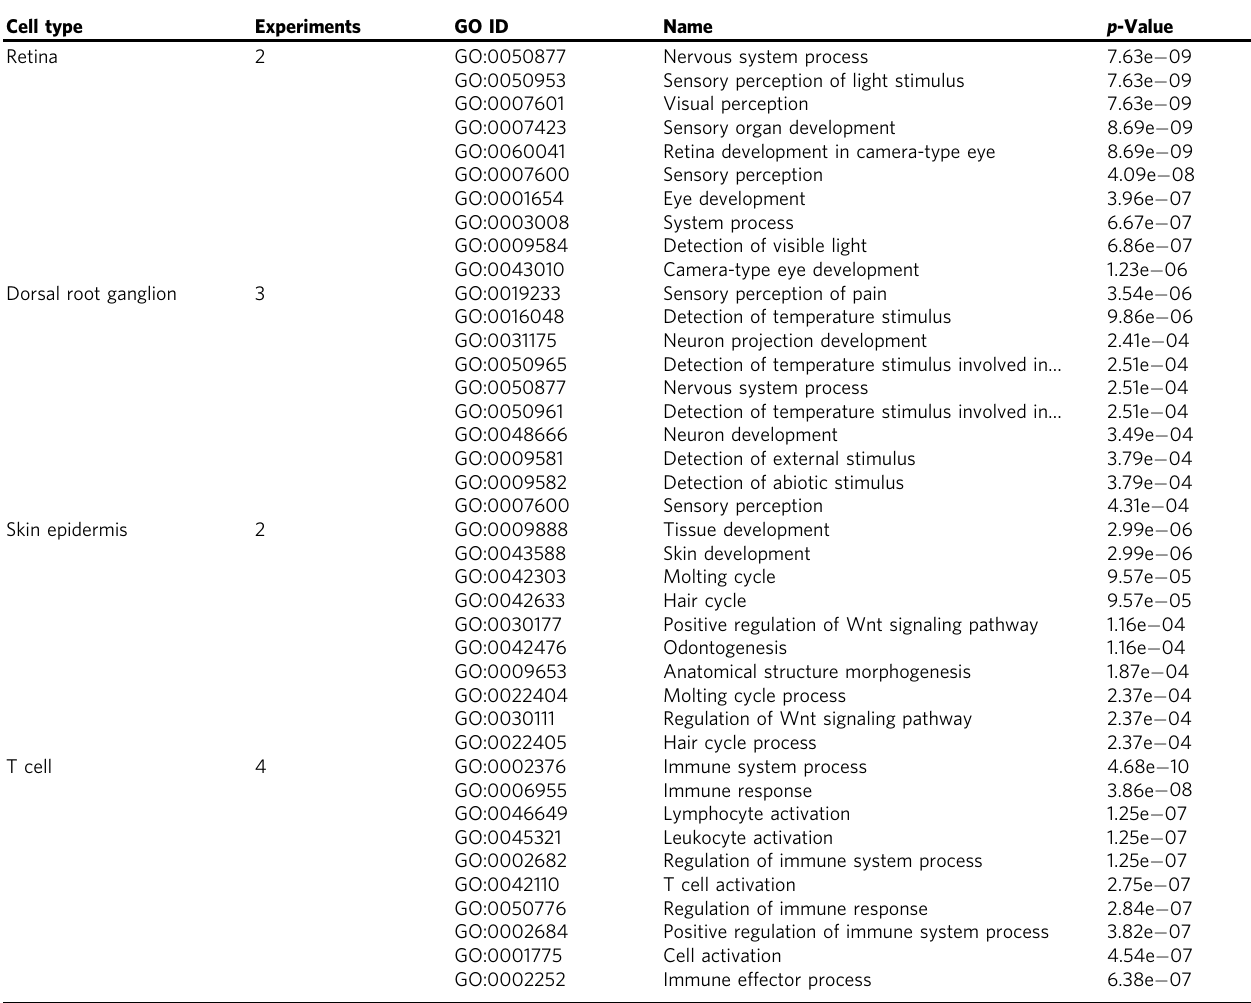
Table 1 Results of GO enrichment analysis Cell